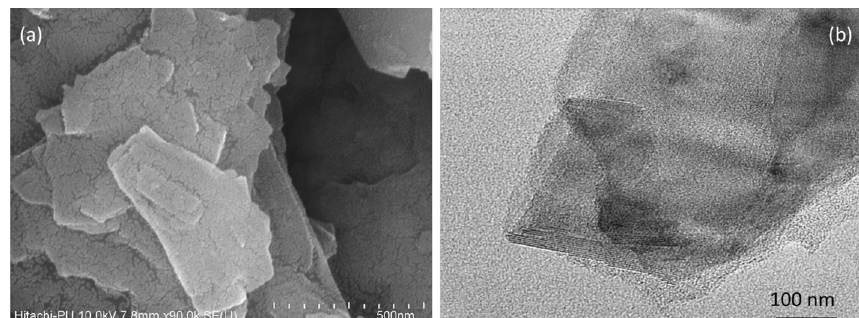
Figure 2. ( a ): FE-SEM; ( b ) HR-TEM image of synthesized MoS 2 nanosheets.